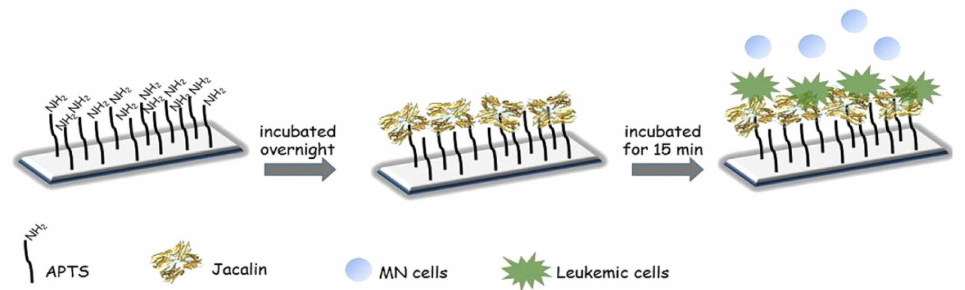
Figure 6. Preparation of impedimetric cytosensors based on a jacalin-modified electrode for the determination of cancer cells. Reprinted with permission from ChemElectroChem. Copyright 2015 Wiley-VCH Verlag GmbH and Co.